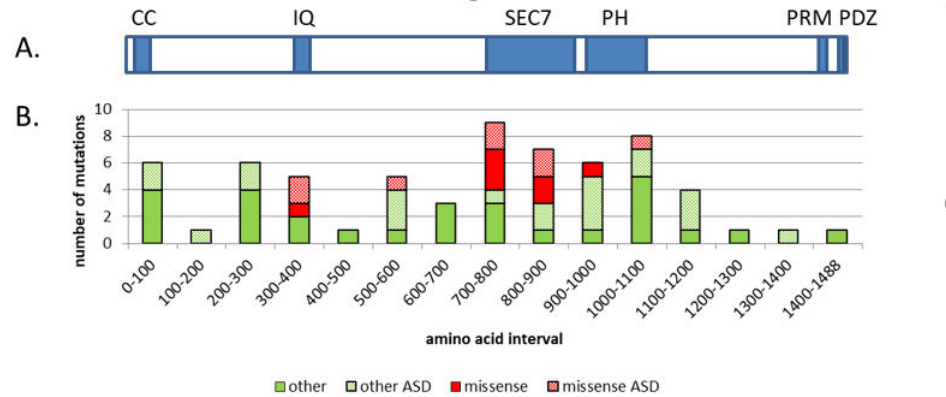
Figure 1. Schematic diagram of the conserved domains found in the human IQSEC2 protein and the distribution of mutations found in IQSEC2 cases. The top panel (A) depicts the protein encoded by the most abundant transcript for human IQSEC2 , which contains 1488 amino acids. The known conserved domains and motifs are shown in blue. They are: CC-coiled coil, IQ–calmodulin binding site, SEC7-catalytic domain for GTP / GDP exchange on ARF, PH-pleckstrin homology domain, PRM–proline-rich motif, and PDZ-PSD-95 binding motif. The bottom panel (B) shows the distribution of mutations found in the IQSEC2 gene (mutations were taken from Tables 2 and 3 from reference [3]) Missense mutations are shown in red; all other mutations (which include intragenic nonsense, duplication / truncation, in-frame deletions, and splicing variants) are shown in green. Hatched red bars show missense mutations associated with ASD. Hatched green bars show all other mutations associated with ASD. The positions of all mutations were arbitrarily chosen as the N terminal starting point. Mutations were considered to be associated with ASD if at least one member of the family was listed as having ASD traits or displaying autistic